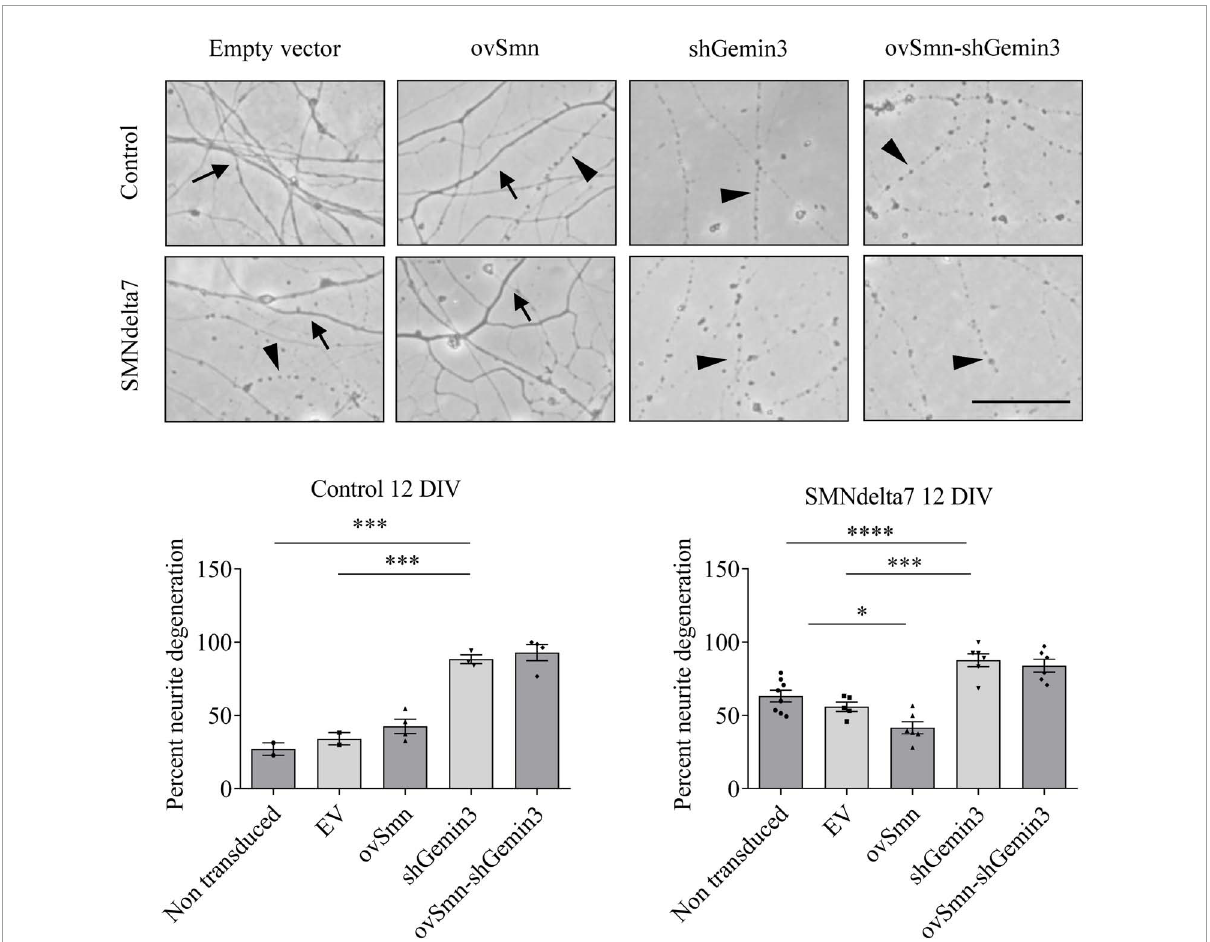
FIGURE7 Increased neurite degeneration by Gemin3 knockdown in motoneurons (MNs). Representative phase contrast images of 12 days cultured control and SMNdelta7 MNs transduced with lentiviral particles containing ovSMN, shGemin3, ovSMN plus shGemin3, or empty vector (EV) constructs. Scale bar, 15 µ m. Arrows indicate non-degenerating neurites and arrowheads signal degenerated neurites (swelling and blebbing). Graph values are the mean of the percentage of degenerating neurites for each condition of nine wells from three independent experiments ± SEM. Asterisks indicate significant differences using one-way Anova with Tukey’s multiple comparisons post-test ( ∗ p < 0.05, ∗∗∗ p < 0.001, ∗∗∗∗ p <